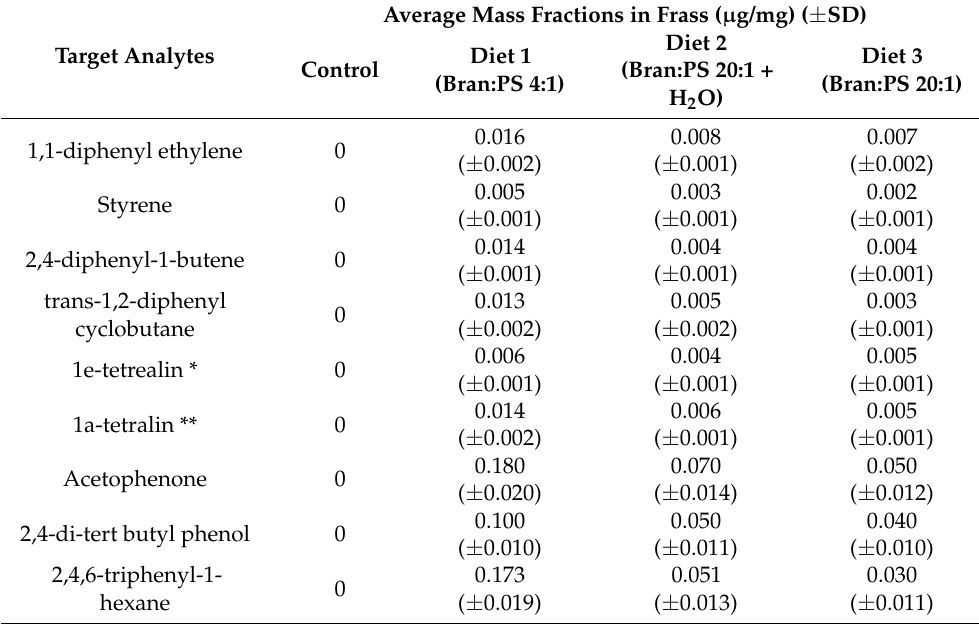
Table 3. Identification and quantification of formed PS monomers and oligomers in insects’ frass. Average Mass Fractions in Frass ( µ g/mg) ( ± SD) Target Analytes Diet 1 Control